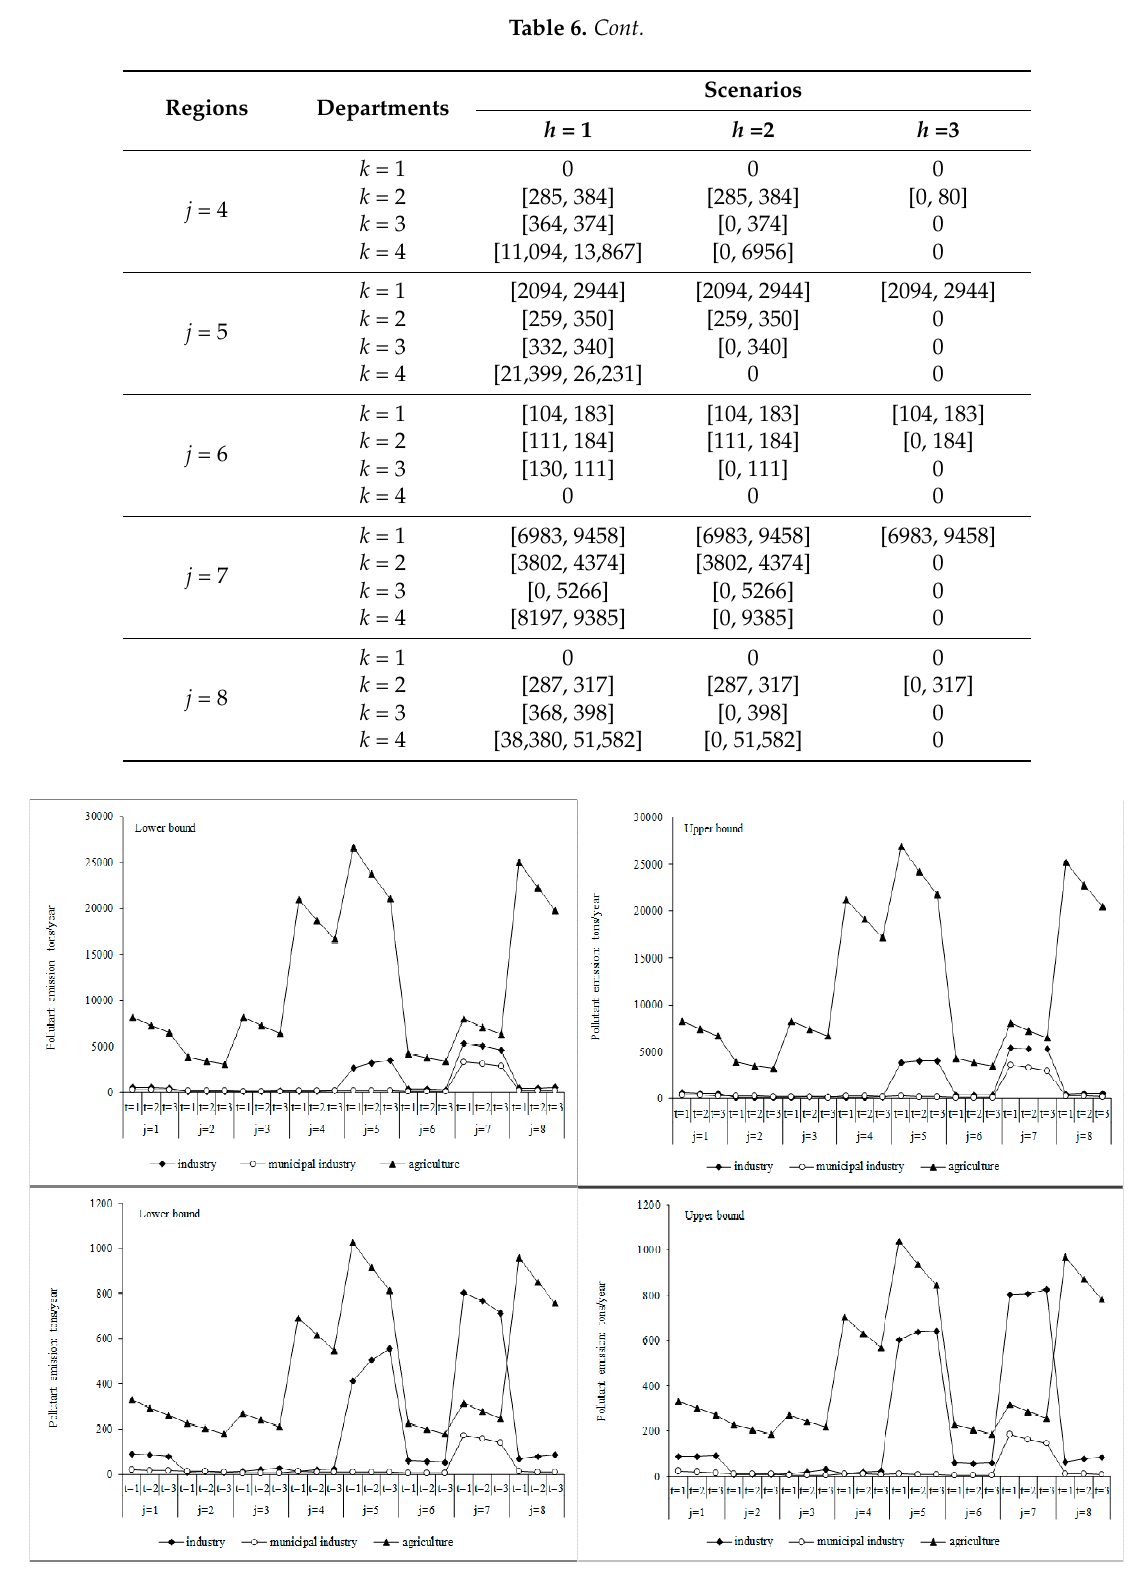
Figure 6. Chemical oxygen demand (COD) and NH 4 -N emissions in the Yinma River Basin.